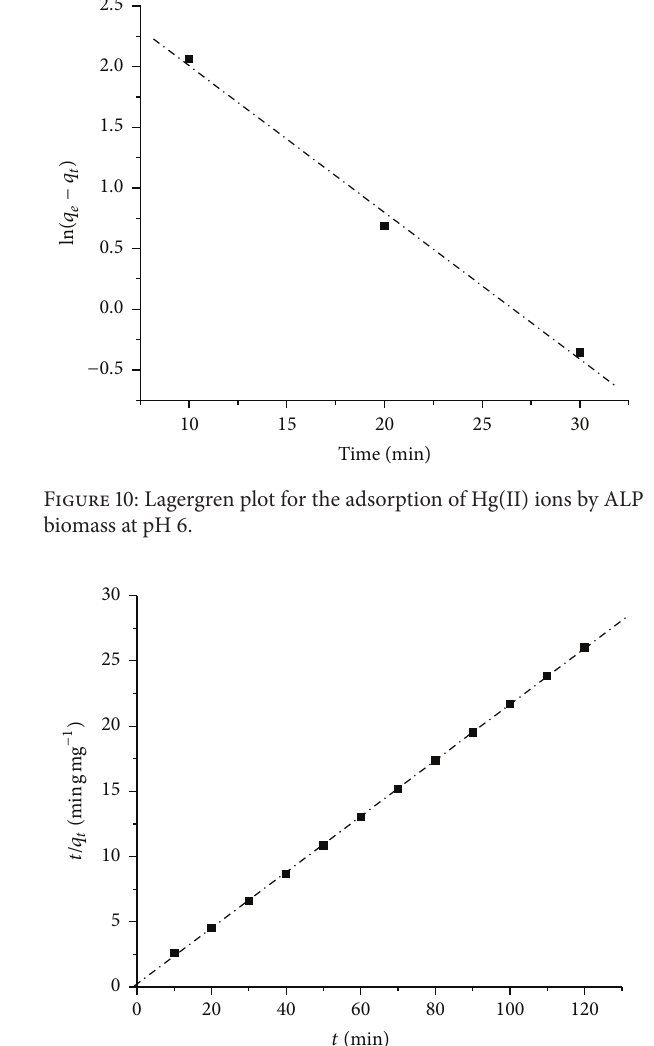
Figure 11: Pseudosecond-order kinetics for the adsorption of Hg(II) by ALP biomass at pH